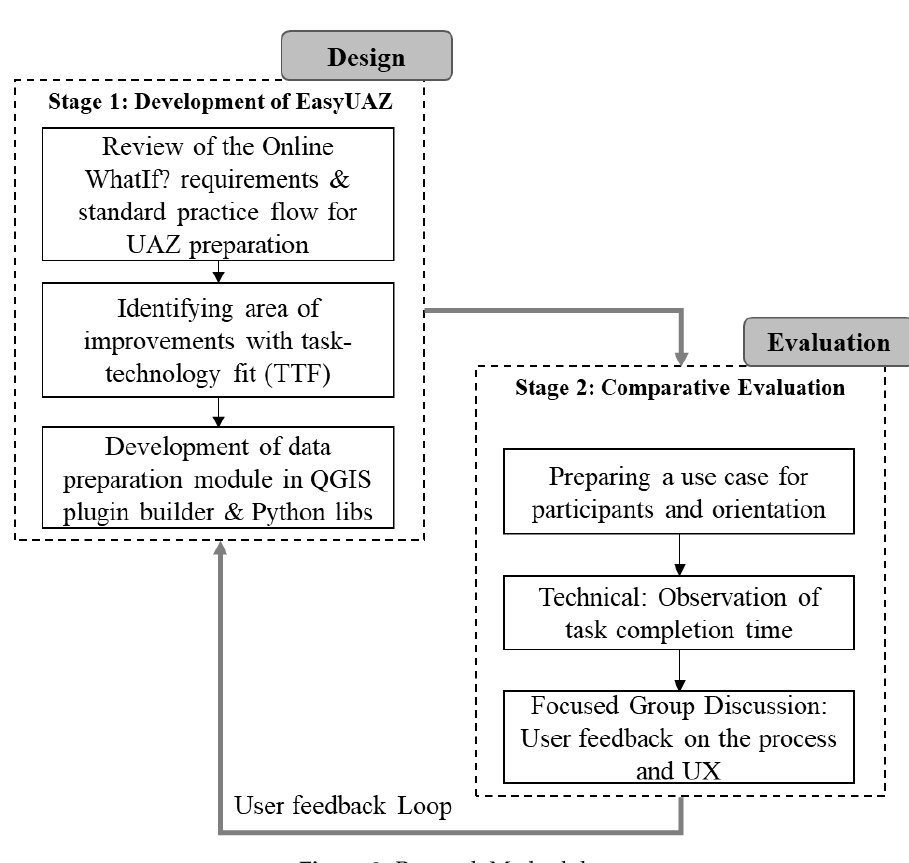
Figure 3. Research Methodology.